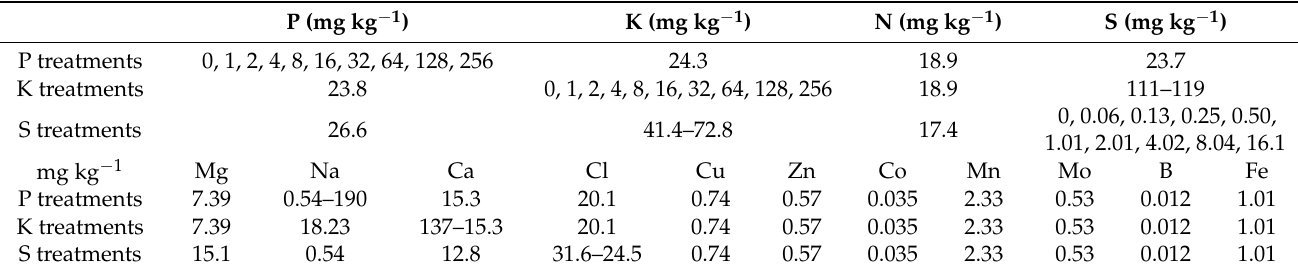
Table 3. Quantity of nutrients added to play sand to create the 30 treatments of P, K and S. All values are in mg kg − 1 .